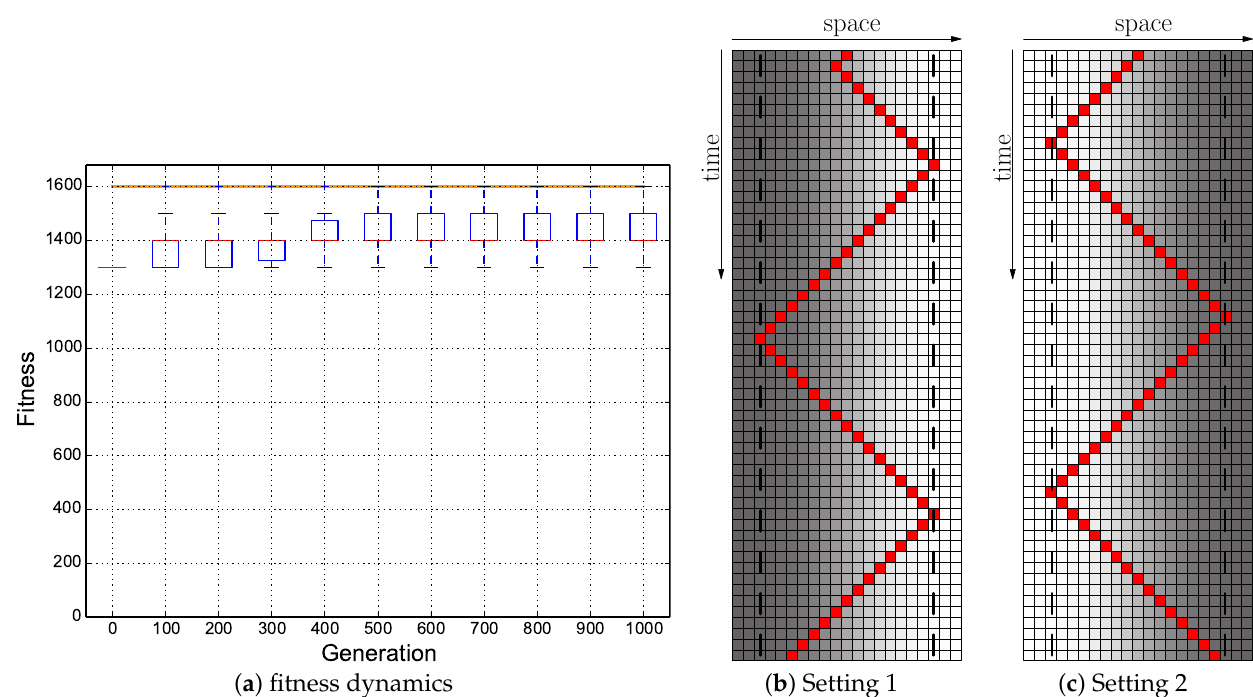
Figure 14. Evolutionary results of the Cumulative + Switch fitness regime starting with the hand-coded ANN (Figure 5a): fitness = F ( 100,0.01,0 ) ; the minimum of both evaluations was used as the fitness value for each genome. ( a ) Fitness dynamics of the evolutionary population. The horizontal orange line indicates the maximum fitness achievable by a reactive Wankelmut controller. ( b , c ) Trajectory of the best performing genome in both environmental settings.